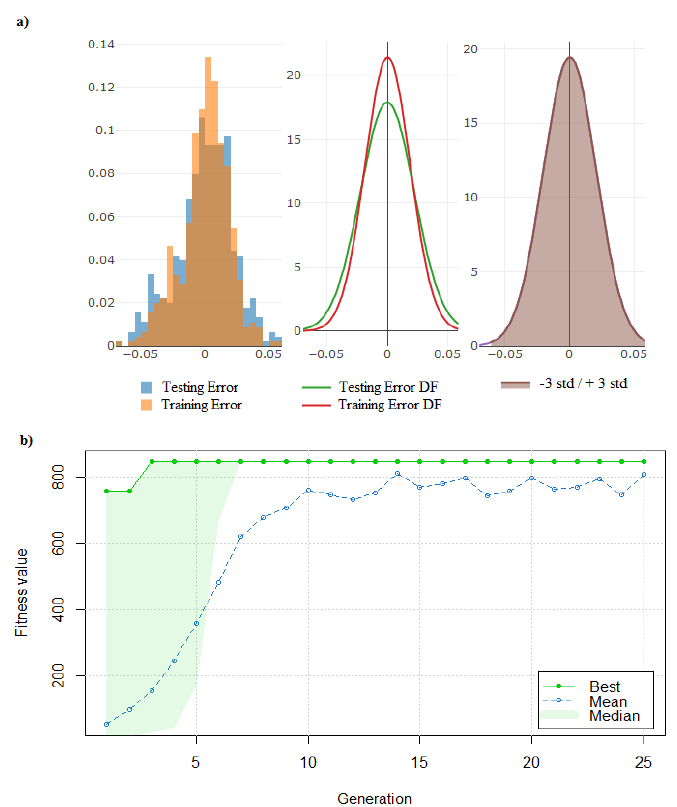
Figure 4. Feed rate model performance; ( a ) Error density function comparison; and ( b ) Genetic algorithm